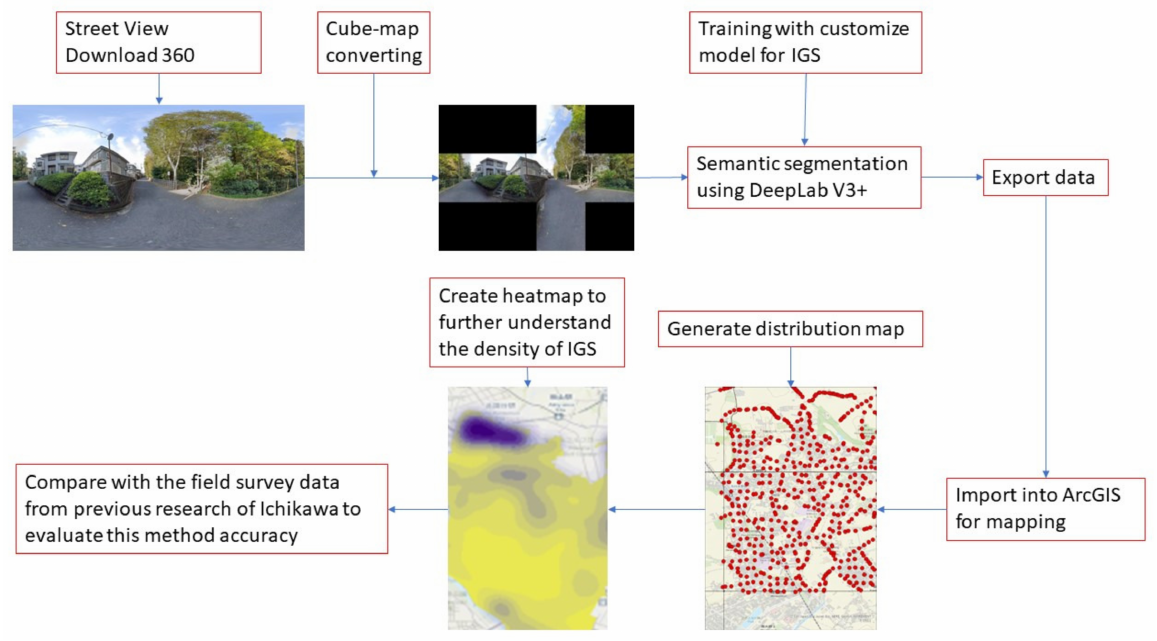
Figure 6. Diagram outlining the process (modified after Ta et al., 2021 and Ta, 2022) [31,47]. Photos downloaded from the Google server were converted to cube map form before processing using Deeplab V3+. The results were used to create IGS distribution and density